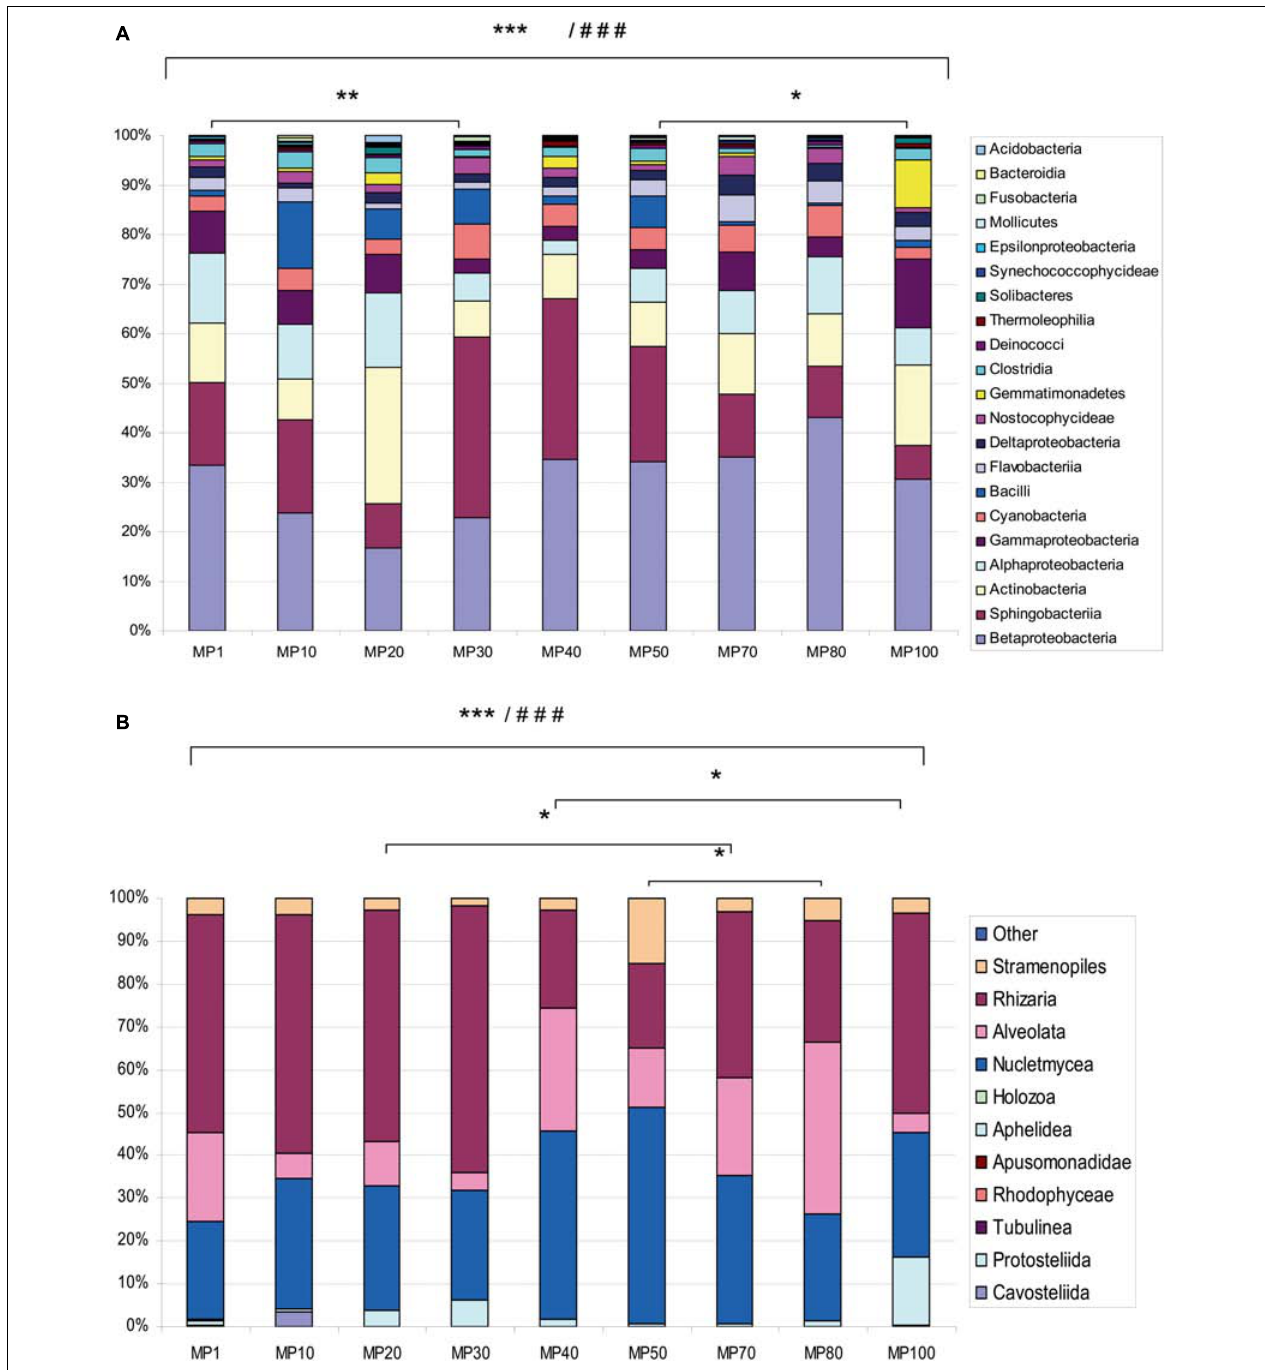
FIGURE 2 | Relative abundances of major classes of bacteria and microeukaryotes. Graphs are based on (A) 16S rRNA and (B) 18S rRNA gene sequencing data, respectively. Relative abundance is expressed as mean of three sampling replicates per site. The “Other” category is the sum of all classifications with less than 3.50% abundance. Comparison of microbial abundance among samples from MPG analyzed by ANOVA ( ### p < 0.0001) and Bonferroni’s Multiple Comparison Test (*** p < 0.001; ** p < 0.01; * p < 0.05).